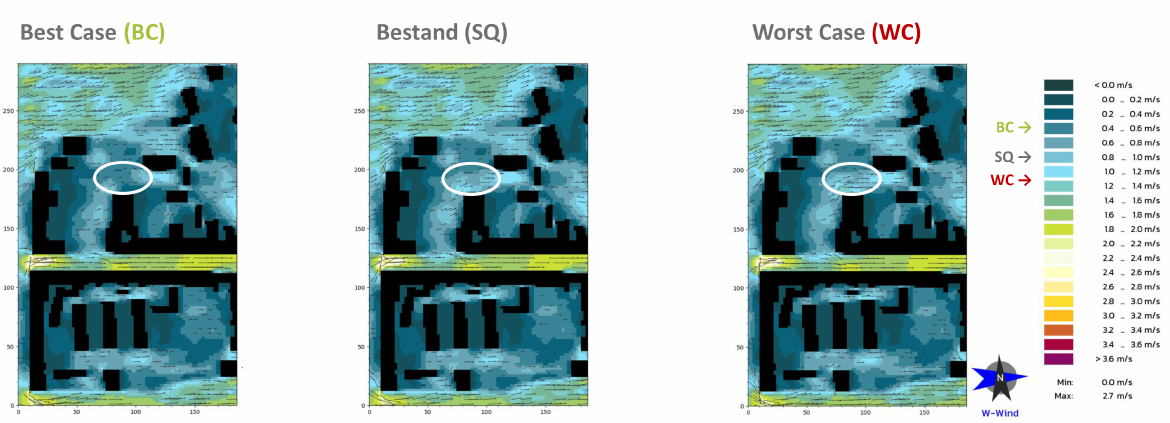
Figure 4. Wind field 3 pm – Comparison between best case (BC), the state of the art (SQ) and the worst case (WC) scenarios. Simulation processing by